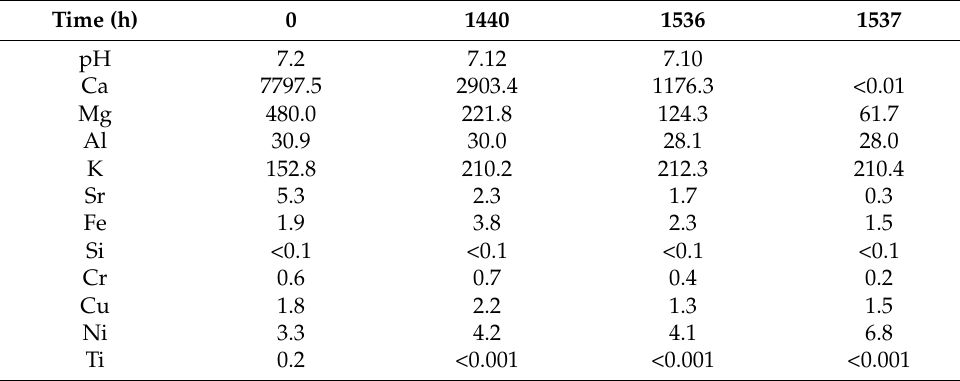
Figure A1. Schematic of the reaction rig and a cross section inside a lined Parr reactor vessel. ISCO is the injection pump, V1 is a Parr reactor vessel, DA is the data acquisition and control. Table A1. Dissolved concentrations (mg/kg) during the reaction, time 0 is before CO 2 injection, 1537 h is after depressurization. The solution pH is also given.